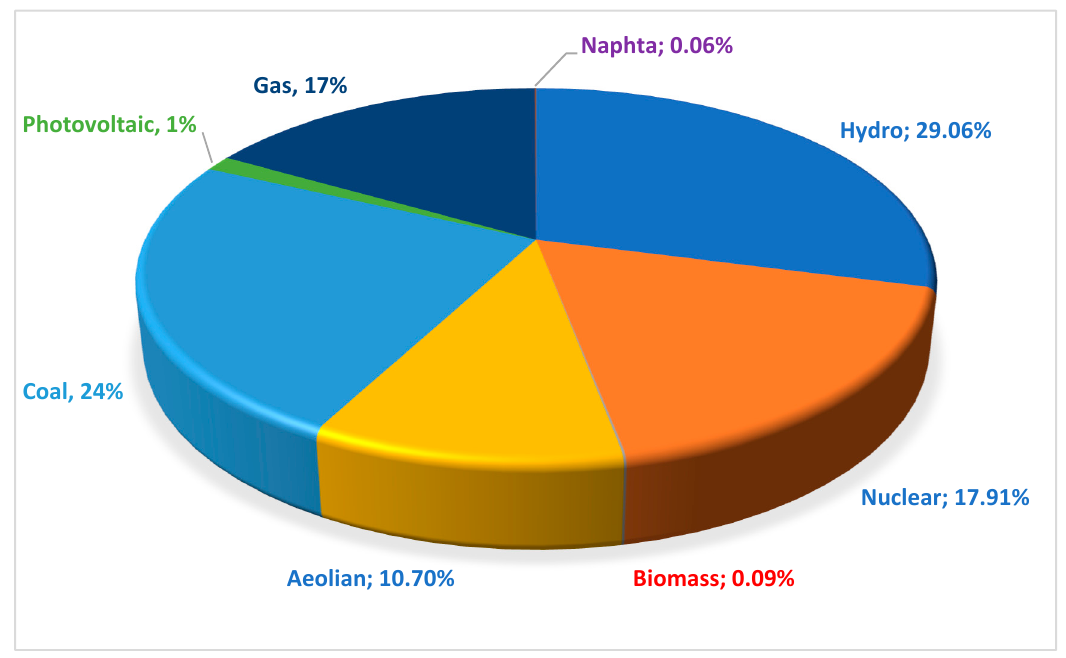
Figure 4. Proportion of energy sources in Romania, in 2017. Source: ANRE.